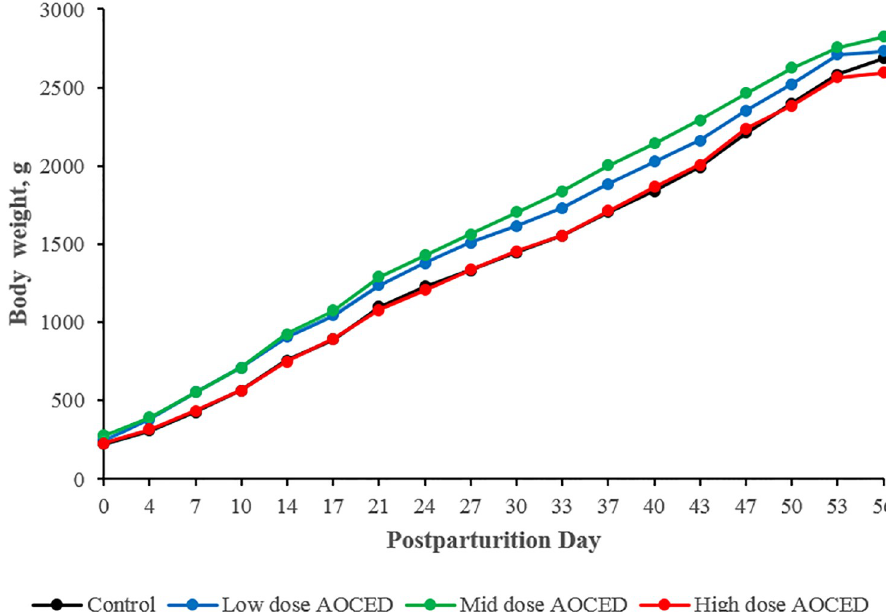
Fig 2. Body weights of puppies before weaning. There were no statistically significant differences between males and females, therefore, genders were combined. Values are shown as group means (n = 10).